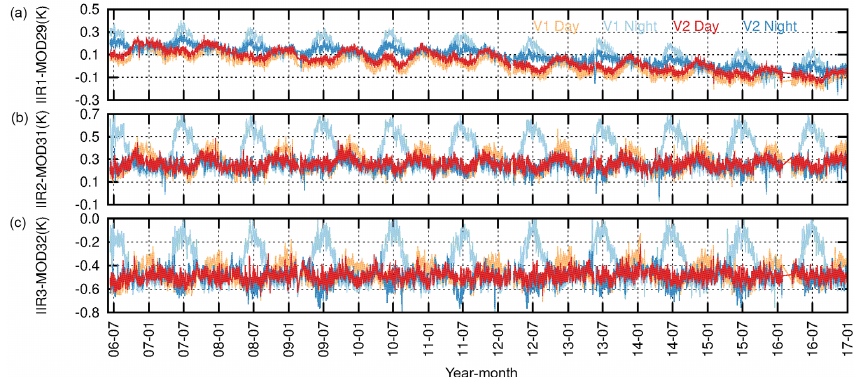
Figure 16. Time series of IIR–MODIS C5 daily average BTDs over oceans for IIR Version 1 (orange: day; light blue: night) and Version 2 (red: day; dark blue: night). (a) IIR1–MODIS29; (b) IIR2–MODIS31; (c) IIR3–MODIS32. Latitude range: 30–60 ◦ N. Temperature range: